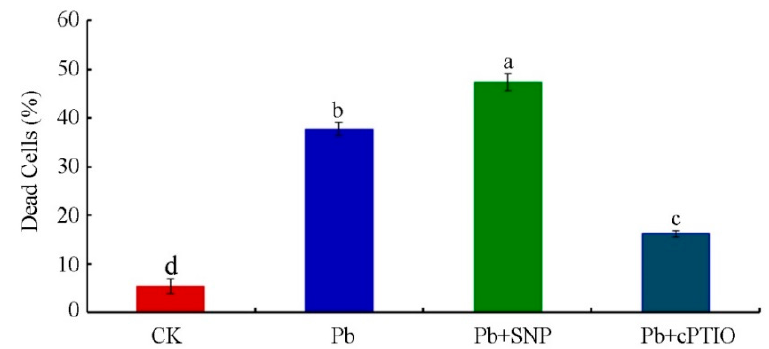
Figure 4. E ff ects of SNP or cPTIO on cell viability in tobacco BY-2 cells treated with 250 µ M Pb(NO 3 ) 2 for 24 h. Bars with di ff erent lowercase letters in each panel are significantly di ff erent ( p < 0.05). CK,